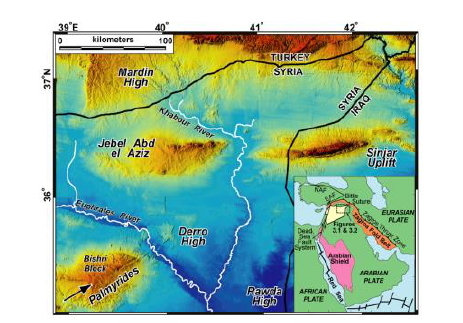
Figure 1. A topographic map showing the Bishri block in Central Syria in the left corner below. Courtesy: M.